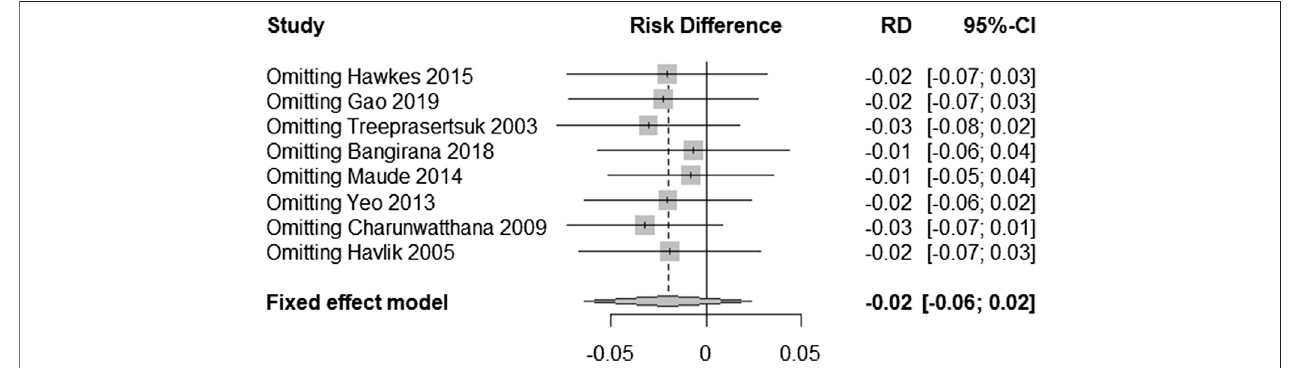
FIGURE 6 | Sensitivity analysis of included